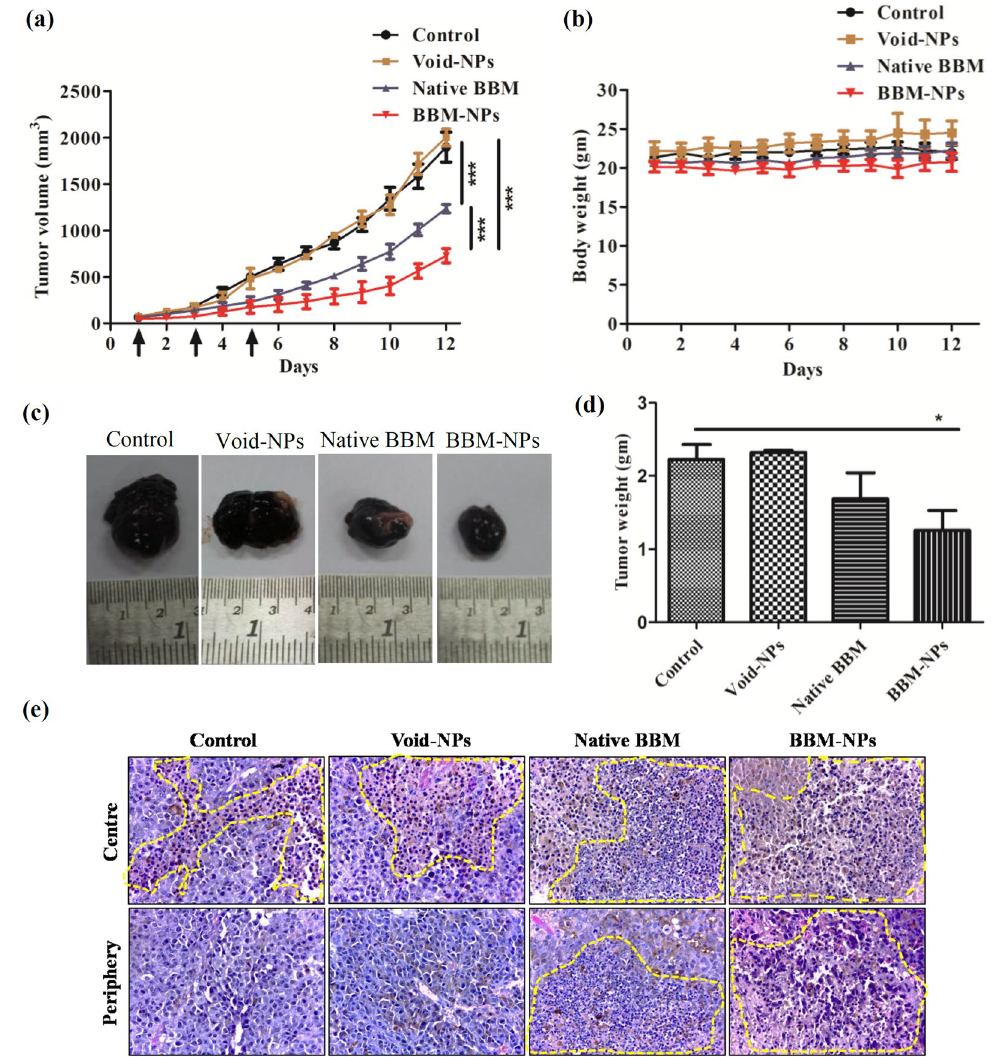
Figure 7. Tumor growth study in C57BL/6 mice melanoma model. The experiment was performed by injecting Native BBM/BBM-NPs/Void-NPs at a dose of 40 mg/kg body weight to mice of different groups intraperitoneally on 1 st , 3 rd and 5 th day. (Detailed protocol is in materials and methods). ( a ) Tumor volume measured in mm 3 . ( b ) Body weight change of the mice. ( c ) The representative picture of tumor of different groups. ( d ) Tumor weight measured in grams. ( e ) Representative H&E stained images of B16F10 tumor tissues obtained from different group of animals shows more necrotic area in BBM-NPs treated tumors than in all other groups. Data represented are as mean ± SEM, n = 4, * p < 0.05, *** p < 0.001 for Native BBM and BBM-NPs treated mice vs.